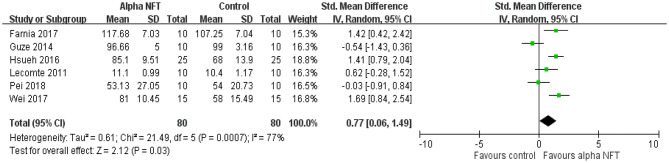
Forest plots for meta-analysis of alpha NFT on episodic memory in healthy participants. SD, standard deviation; Std, standardized.